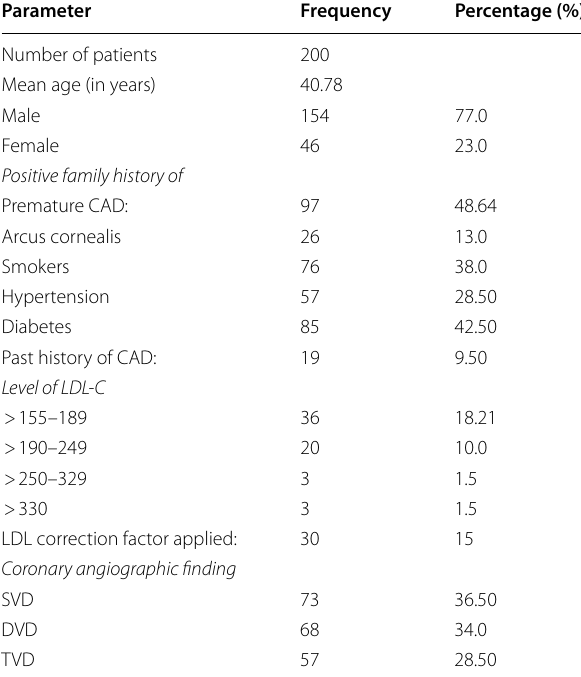
Table 7 Baseline